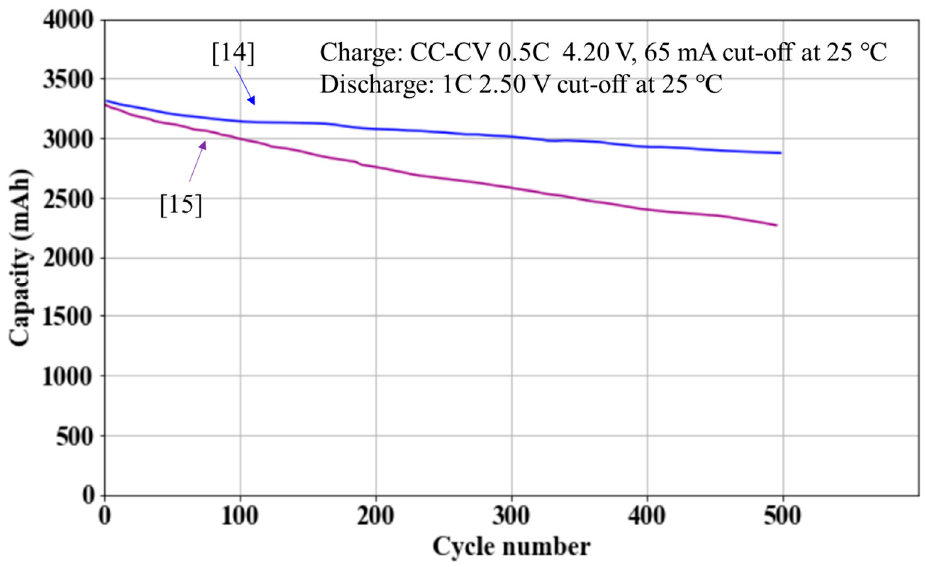
Figure 6. Inconsistency observed in the cycle characteristics from different sources for Panasonic NCR18650B cells.